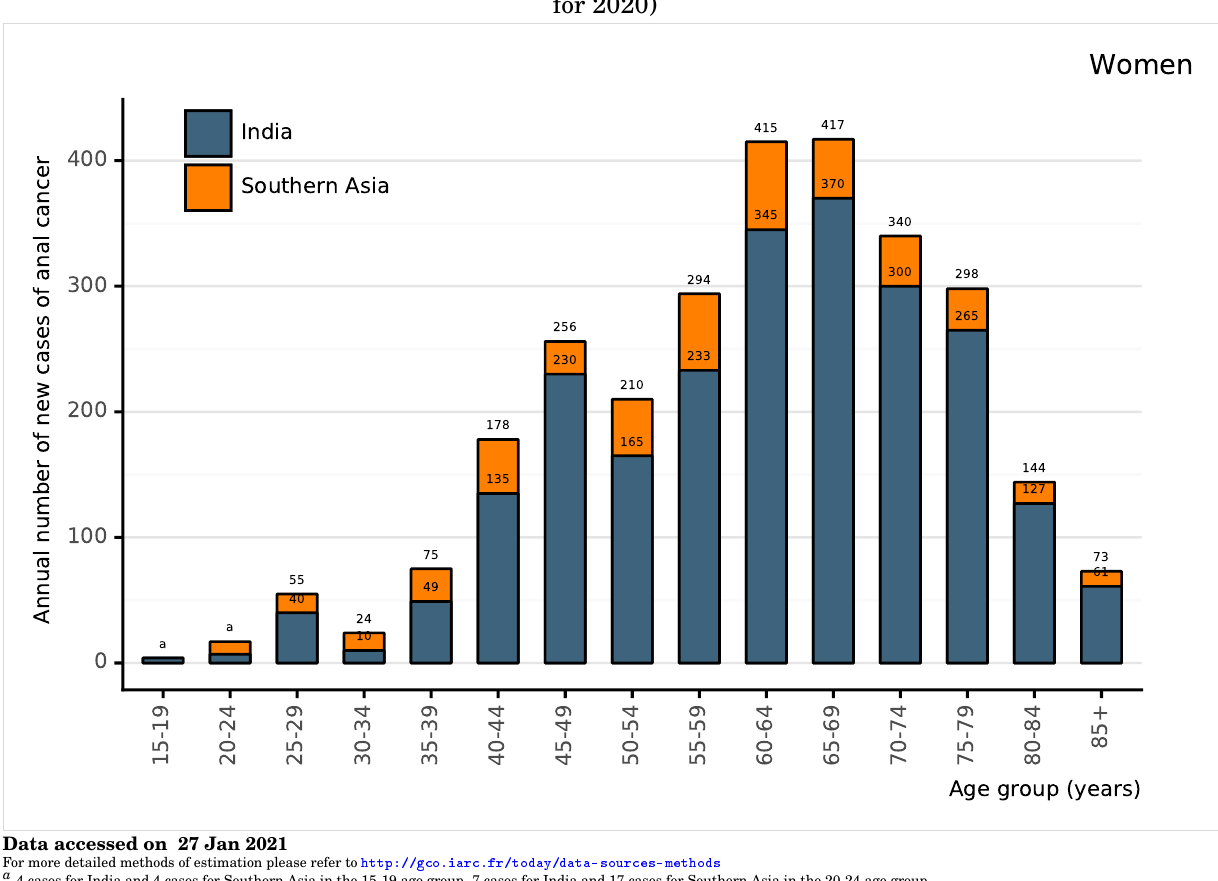
Figure 78: Annual number of new cases of anal cancer among women by age group in India